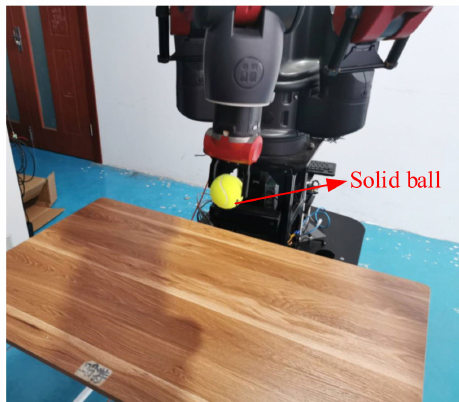
Figure 22. Grasping solid ball.